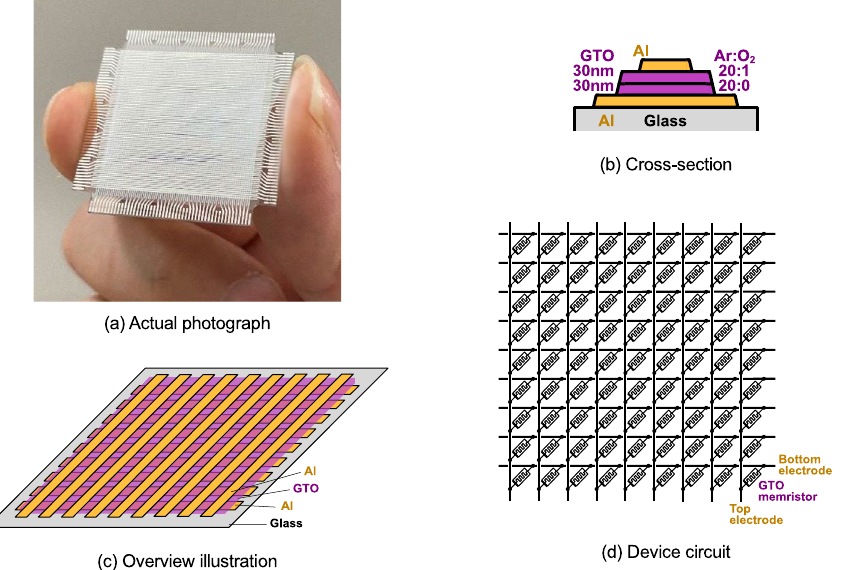
Figure 1. GTO memristor. ( a ) Actual photograph. ( b ) Cross-section. ( c ) Overview illustration. ( d ) Device circuit. A lower oxygen-poor and upper oxygen-rich GTO layers are stacked with different oxygen concentrations. The GTO memristors are formed at cross points in a crossbar array.